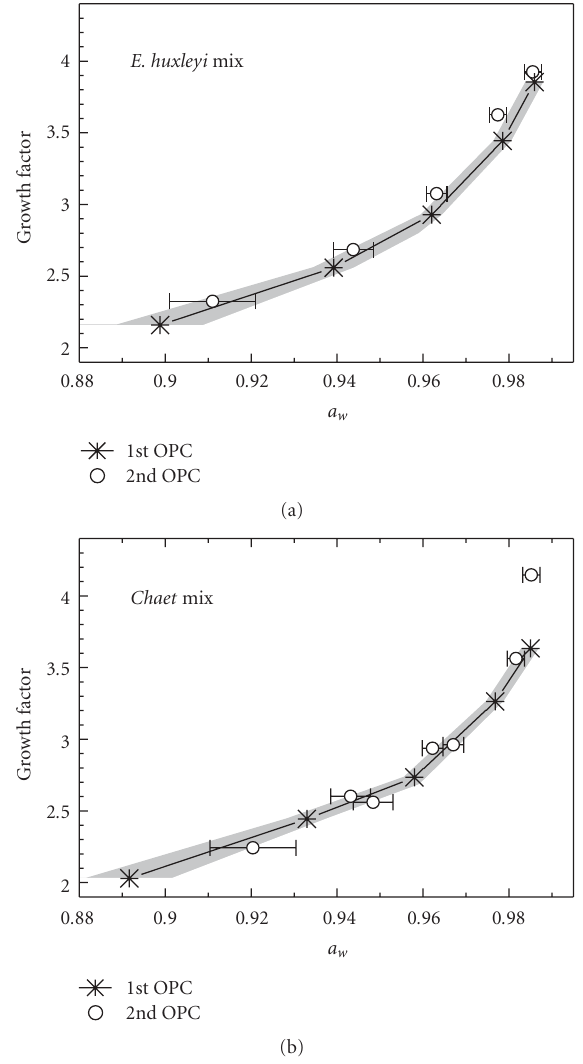
Figure 5: Comparison of hygroscopic growth measured with LACIS at two di ff erent positions of the LACIS flow tube, that is, after di ff erent residence times of 3 and 10